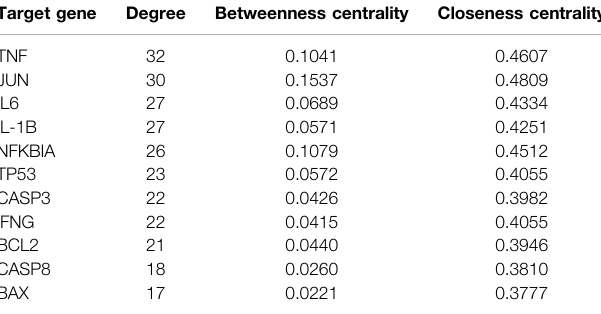
TABLE 5 | Target gene network and node characterization parameters. Target